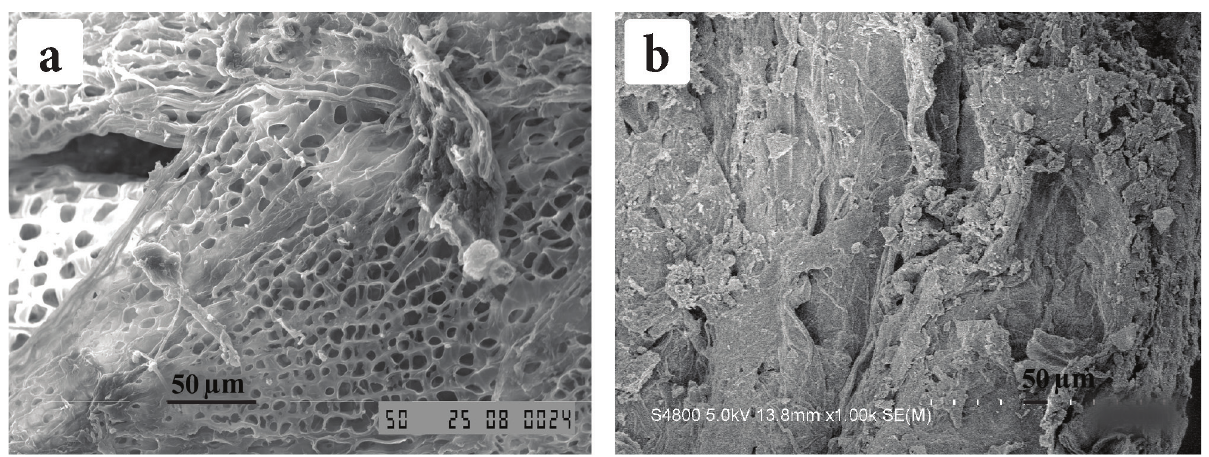
Figure 1: SEM images of a) raw peat material, b) modified